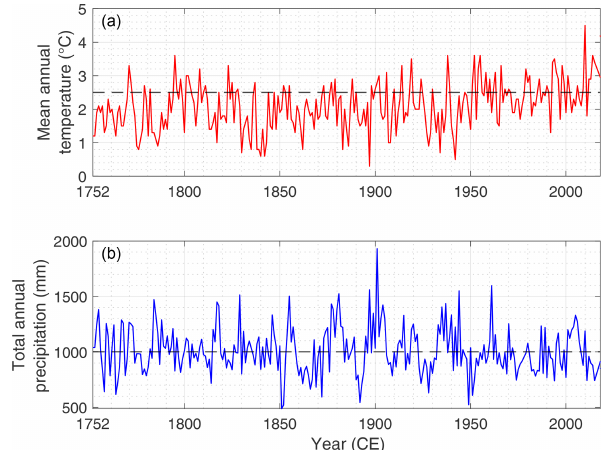
Figure 8. Reconstructed and observed evolution of (a) mean annual temperature and (b) total precipitation amounts for Terskol weather station, based upon proxy data (tree ring reconstructions) and mea- surements from nearby weather stations (Mestia, Pyatigorsk and Mineralnye Vody). The dashed horizontal line represents the 1981– 2010 annual reference values (2.6 ◦ C and 1001.1mmyr − 1 w.e.). We refer to the text and Table 2 for more details.